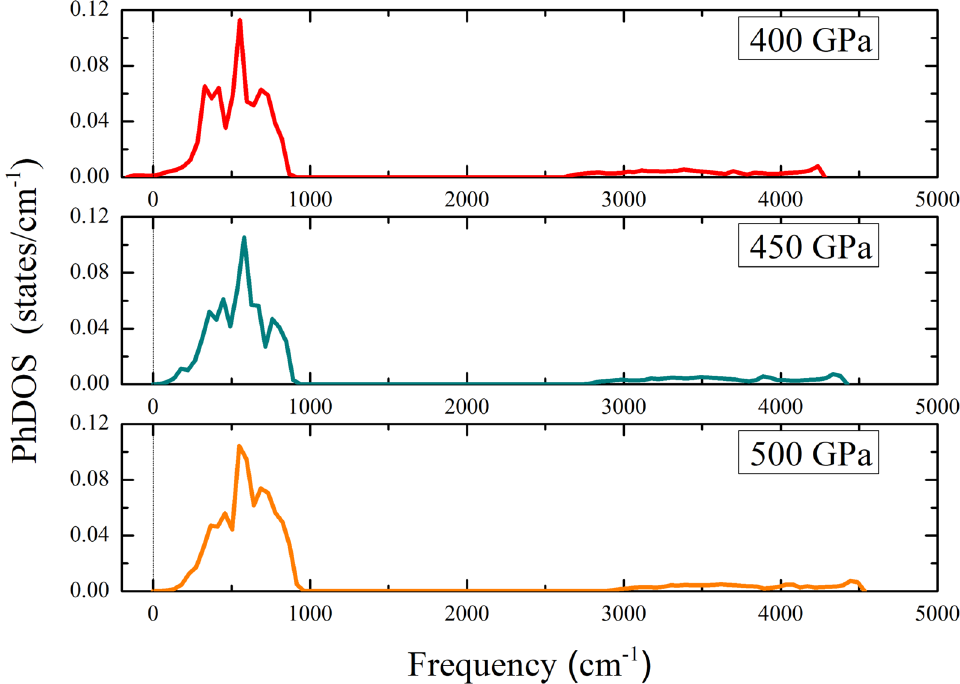
Figure 6. The phonon density of states of the Cmcm structure at a pressure of 450 GPa, 450 GPa, and 500